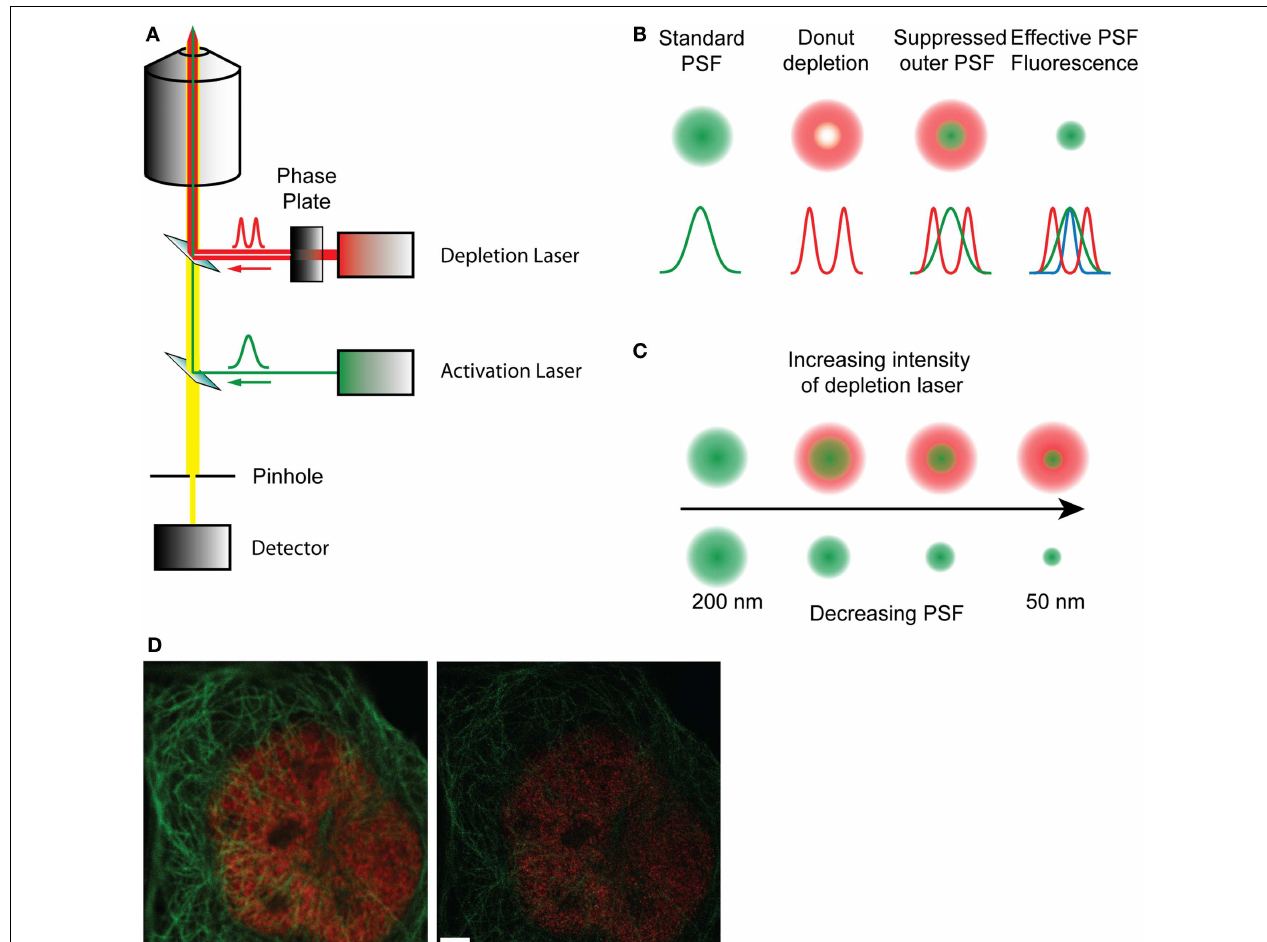
increasing intensity of the depletion laser the shape of the donut changes, decreasing the size of the inner ring and therefore reducing the effective PSF of the fluorophore from 200nm to about 50nm, effectively increasing resolution. (D) A raw confocal (left) and STED image (right) showing the improvement in detail and resolution. Red stain – nuclear pores, green stain – microtubules. Scale bar,